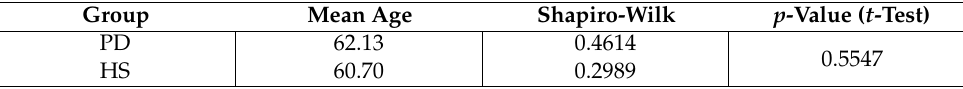
Table 1. Comparison between the mean age of PD and HS groups.